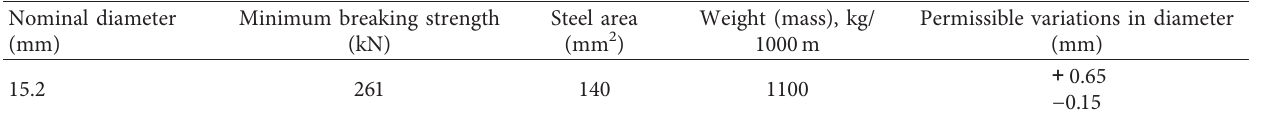
Figure 2: Electrolytic corrosion test of prestressed anchor cable. (a) Steel support frame; (b) strain gauge transducer; (c) sealing of the vessel; (d) appliance of the test. Table 1: Parameters of anchor cable